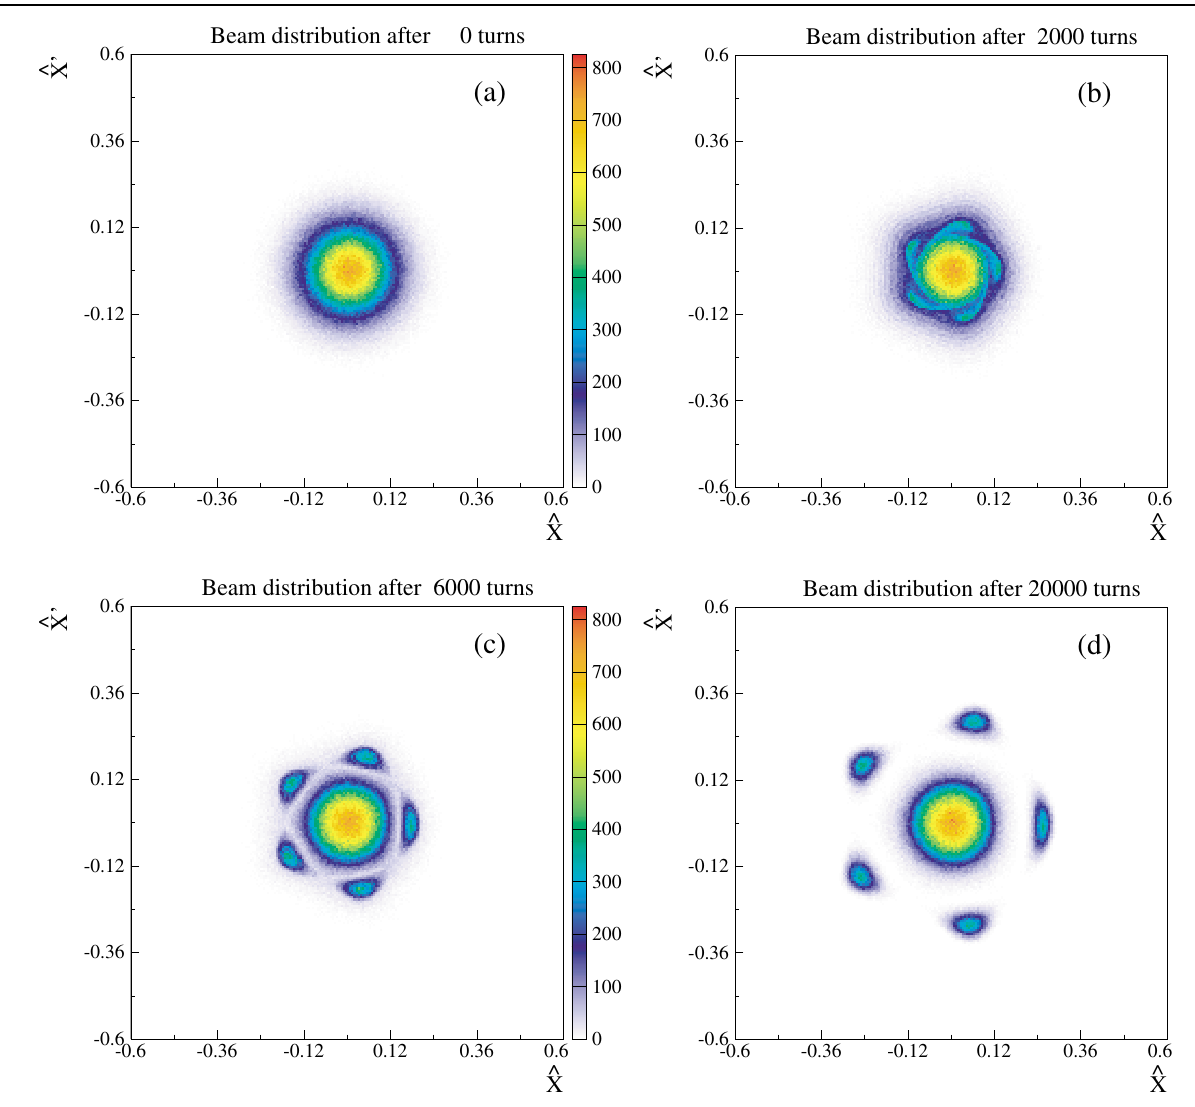
FIG. 10. (Color) Beam distribution during the trapping process with five islands ( 8 : 1 (cid:9) 10 5 initial conditions). The initial distribution is a Gaussian centered on zero, with standard deviation (cid:21) (cid:1) 0 : 08 , (cid:14) (cid:1) (cid:6) 2